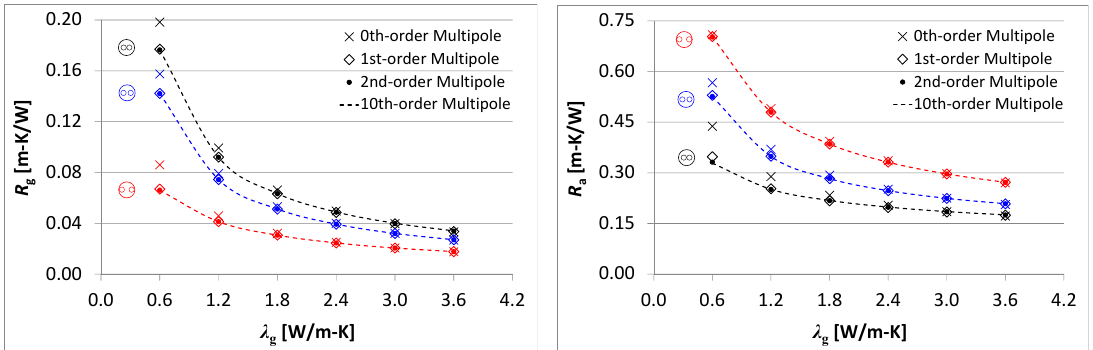
Figure 5. Grout thermal resistance ( R g ) and total internal resistance ( R a ) for close (2 x p = 32 mm), moderate (2 x p = 43 mm) and wide (2 x p = 64 mm) configurations with 2 r b = 96 mm and λ = 4 W/m-K.